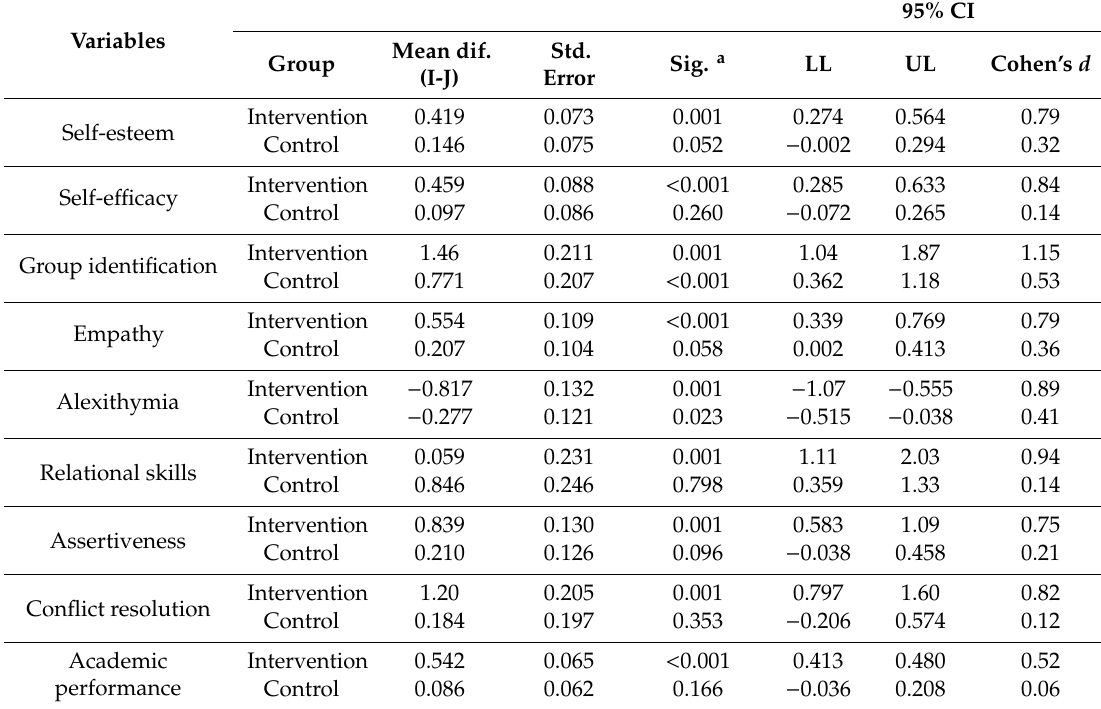
Table 5. Simple e ff ects